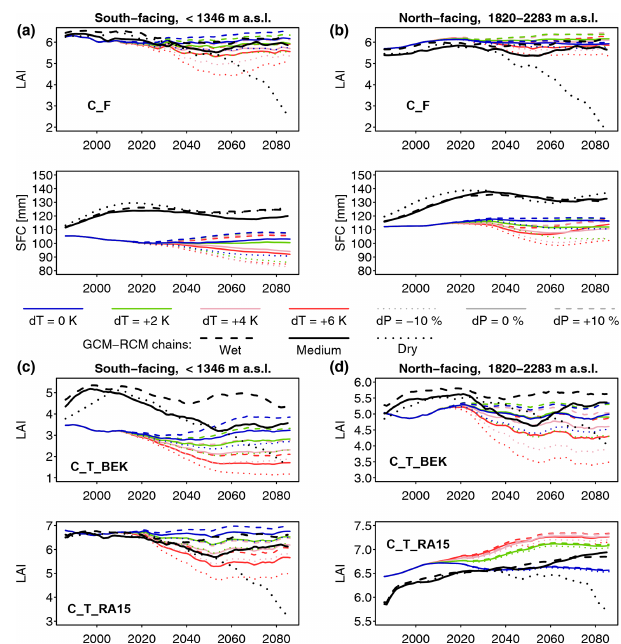
Figure 9. (a) Annual maximum LAI (top) and rooting zone storage SFC (bottom) under idealized climate change scenarios, simulated using coupled FORHYCS (C_F). LAI and SFC are averaged over the cells belonging to the lowest elevation class with south-facing slopes (same stratification as for Fig. 6. The results are shown as 30-year rolling means. In the delta change runs, both LAI and SFC generally increase under wetting delta runs and decrease under dry- ing delta runs, although trends are not always monotonic. While the wet and medium scenarios are in the same range as the delta runs, the dry scenario leads to a marked decrease from about 2050. (b) Same as panel (a) but for the highest elevation class with north- facing slopes. Also here, LAI increases under wet scenarios and de- creases under dry scenarios. SFC trajectories show large differences between scenarios. (c) LAI simulated with TreeMig, with the two different soil parameterizations (C_T_BEK and C_T_RA15). Note the different scales on the y axis. LAI simulated with C_T_BEK is markedly lower than for C_F, whereas the C_T_RA15 values are somewhat higher. (d) Same as panel (c) but for the highest elevation class with north-facing